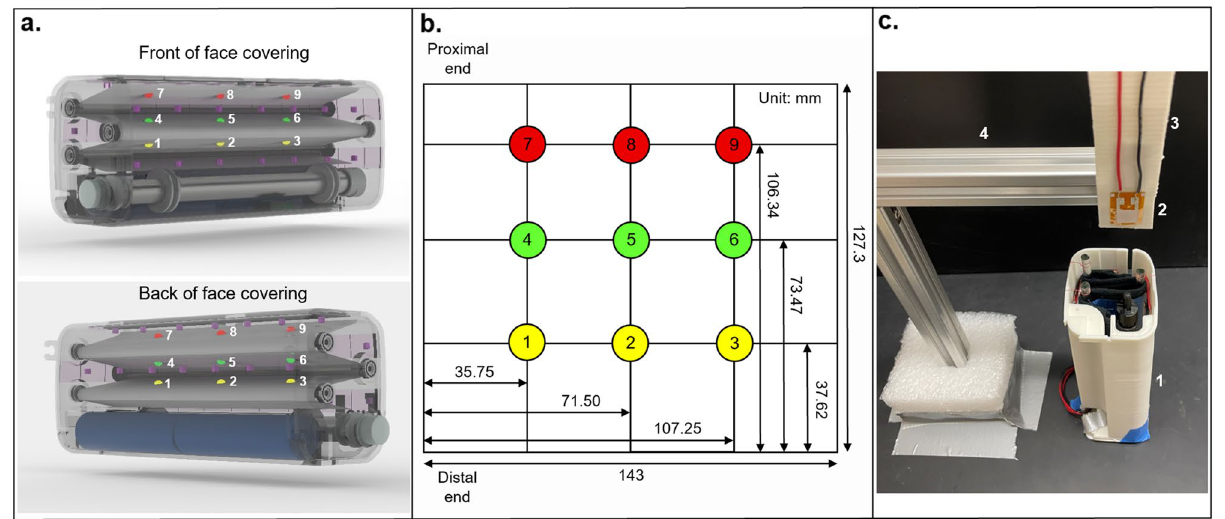
Figure 5. Locations of UV sensor placement on the face covering inside ARMOR ( a ), coordinate map of UV sensor placement on the face covering ( b ), and experimental setup using a ZnO-based UV sensor ( c ). The coordinate map and locations of sensor placement are numbered and color-coded by row, showing the precise locations of the UV sensor during testing relative to both the face covering and the other components of the device. Four components of the experimental setup are shown: the ARMOR prototype connected to a not shown external power supply ( 1 ), the Zn–O-based UV sensor ( 2 ), electrical wires running from the sensor to a not shown multimeter which recorded electrical resistance ( 3 ), and an adjustable tower clamp used to hold the sensor in place while resistance data was measured ( 4